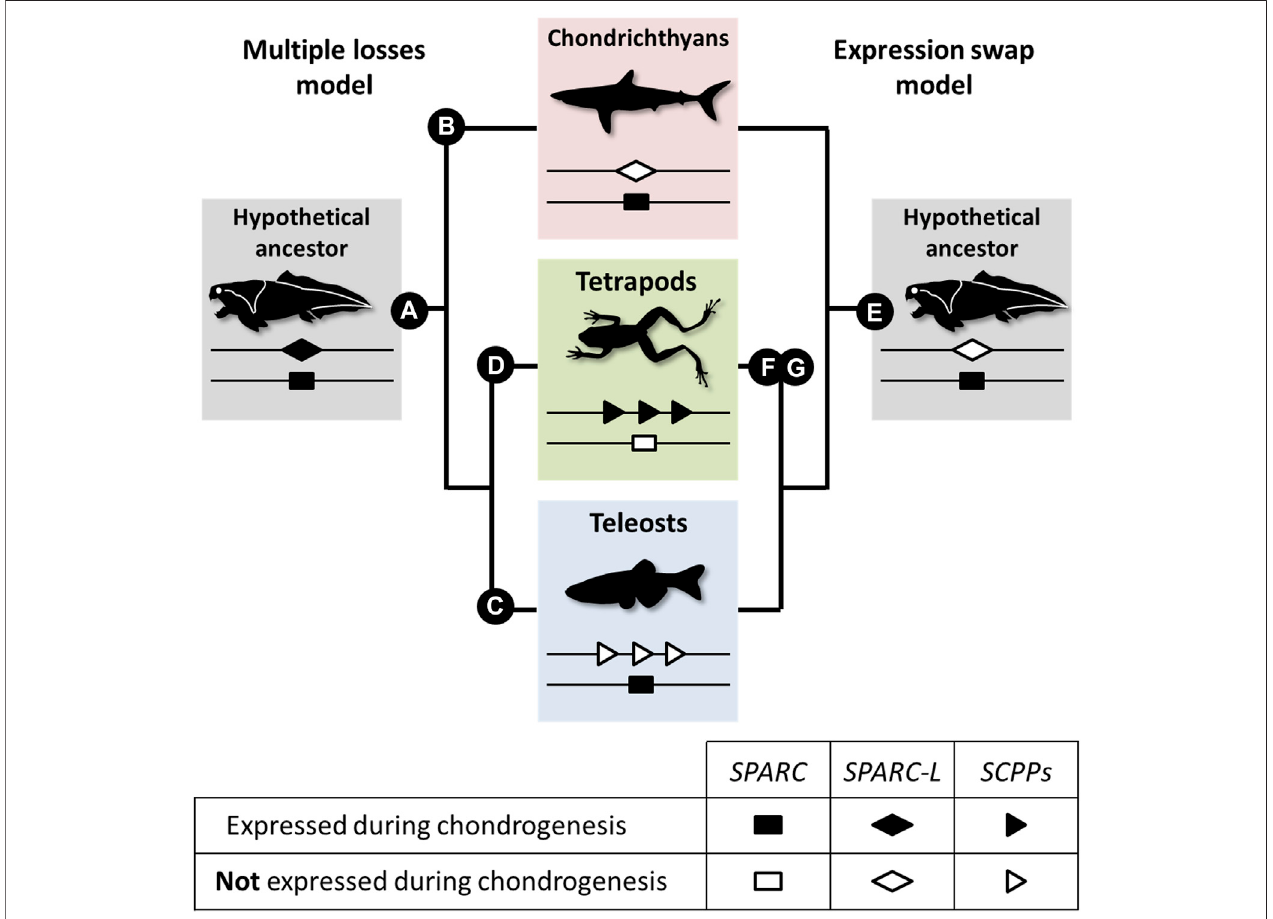
FIGURE 5 | A model for the evolution of the SPARC / SPARC-L / SCPP cartilaginous expression in jawed vertebrates. Evolutionary changes are polarized onto vertebrate cladograms. According to the “ multiple losses ” model (left) , the mineralizing cartilage of the jawed vertebrate last common ancestor expressed both the SPARC and SPARC-L ancestral genes (A) . This expression was inherited by the SCPP members when they evolved through SPARC-L local duplications. Expression losses occurred at leastthree times independentlyindistinctlineages: SPARC-L expression waslostin chondrichthyans (B) , SCPP expression waslost inteleosts (C) and SPARC expression was lost in tetrapods (D) . According to the “ expression swap ” model (right) , the mineralizing cartilage of the jawed vertebrate last common ancestor only expressed SPARC (E) , a situation which remained unchanged in the chondrichthyan and teleost lineages. However, the tetrapod lineage experienced drastic regulatory changes at both loci, leading to the activation of the SCPP genes (F) and the repression of SPARC (G) in chondrocytes.